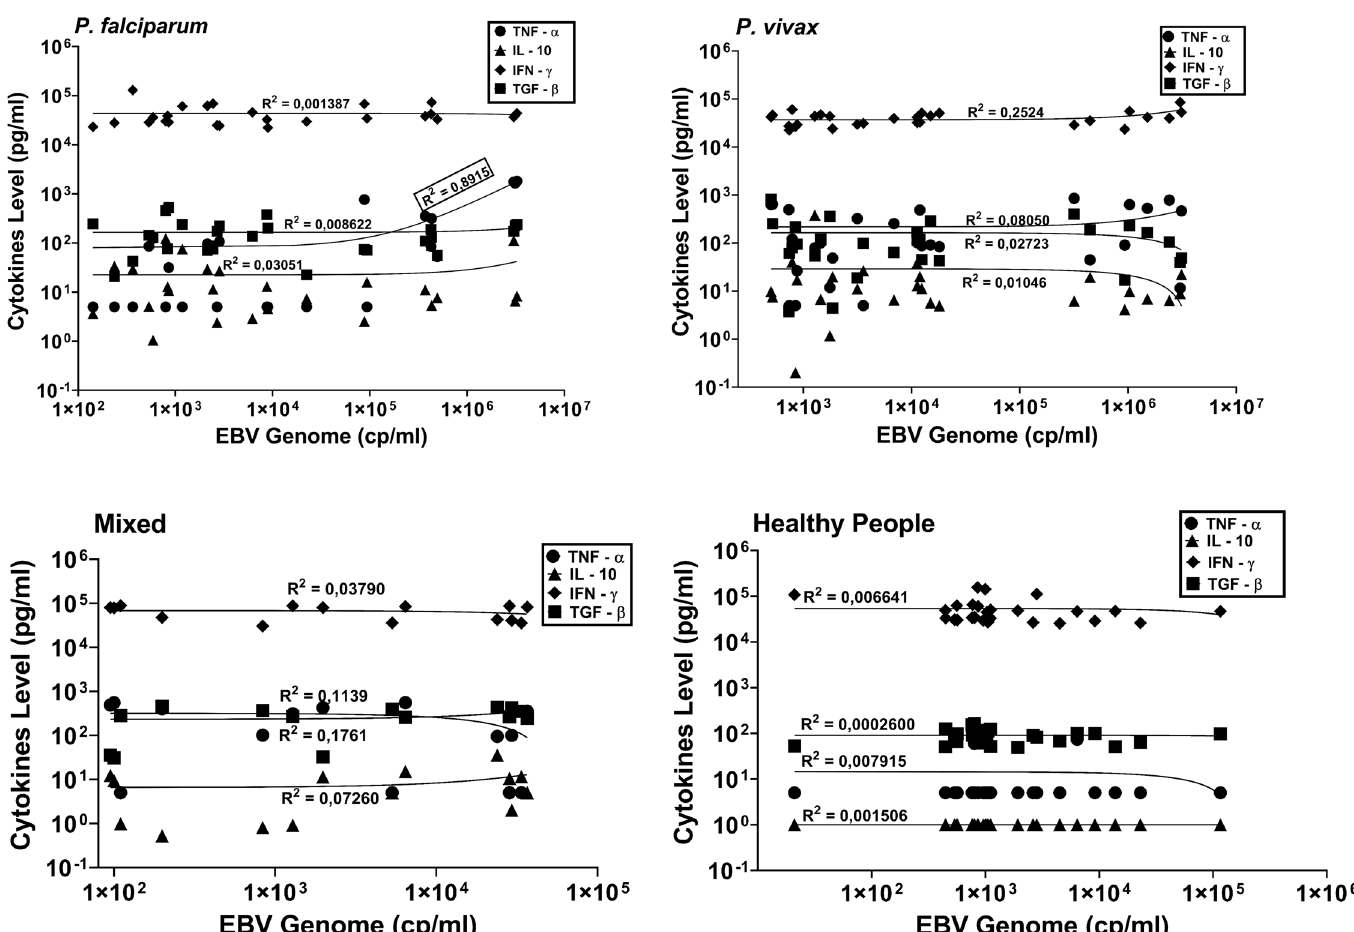
Fig 5. Comparison of circulating EBV genome levels and cytokine levels in (a) P . falciparum cases, (b) P . vivax cases, (c) Mixed cases and (d) healthy controls. Statistical analysis was done by linear regression.